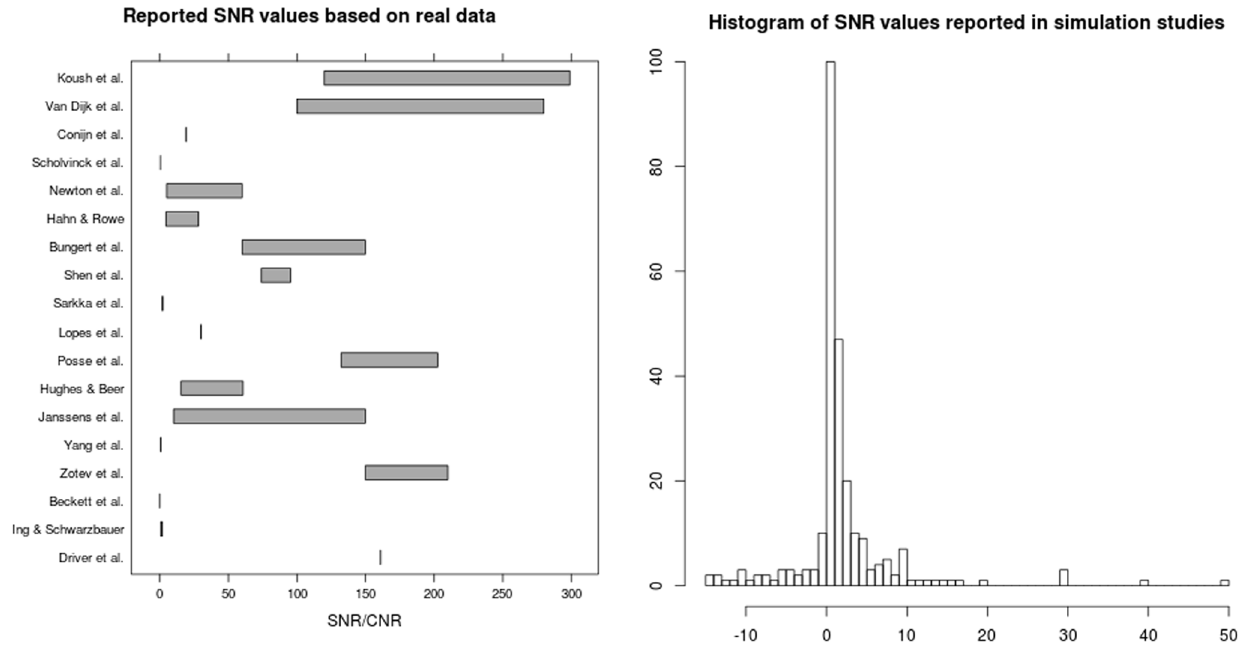
Figure 1. Overview of reported SNR values in real data (left panel) and simulated data (right panel). [ 17,46–61 ] .